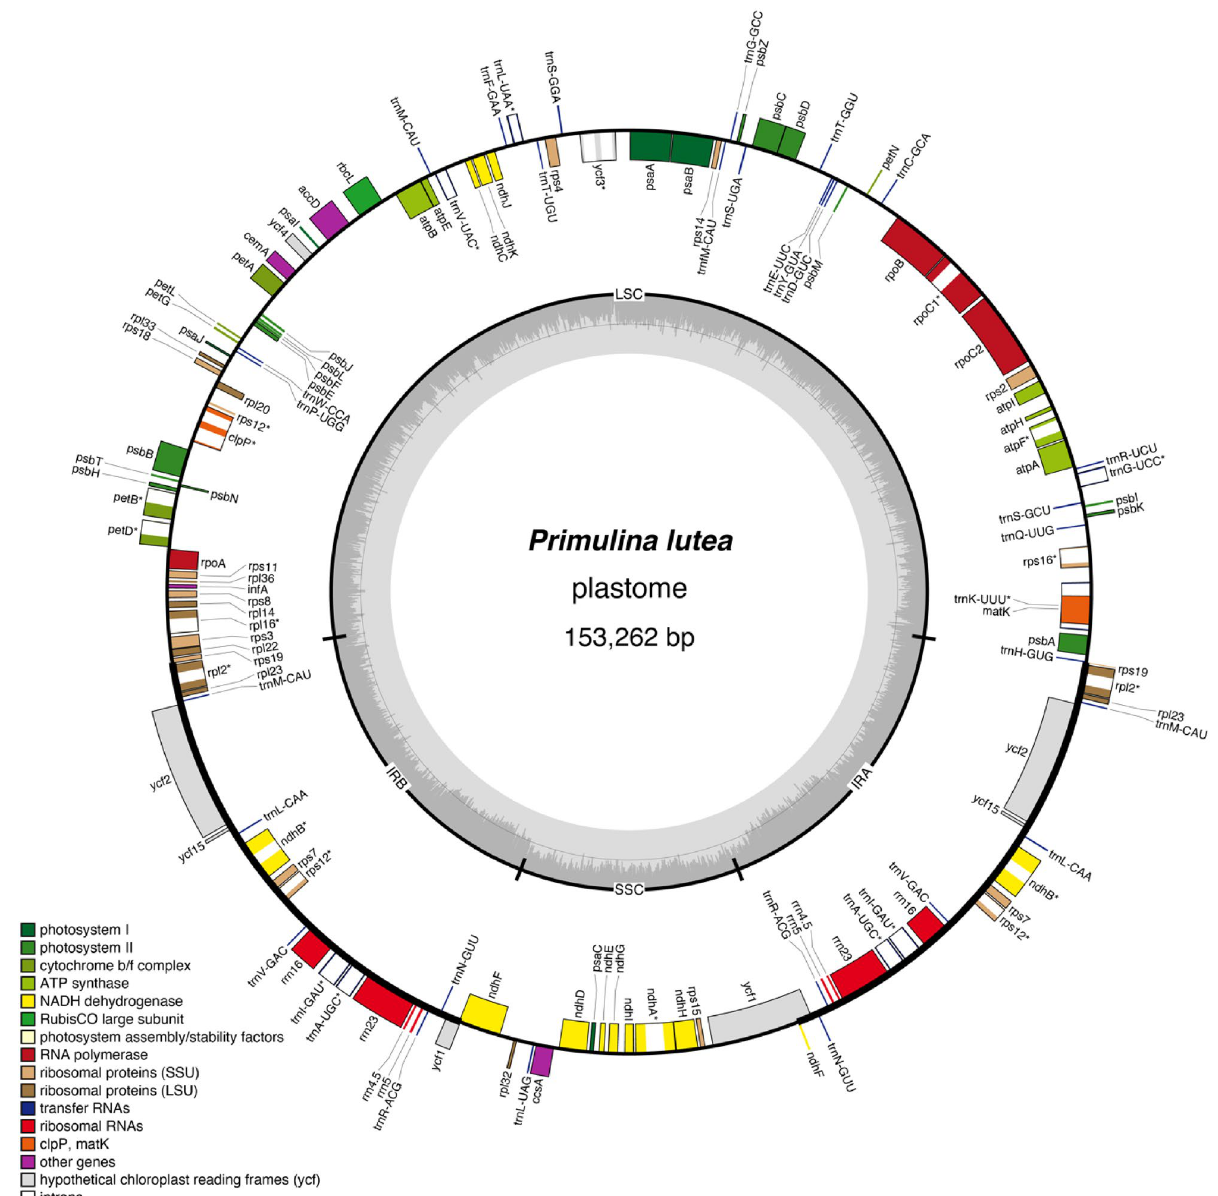
Figure 1. The plastome map of Primulina lutea . Genes drawn on the inner side of the outer circle are transcribed clockwise, and those on the outer side are transcribed counterclockwise. IRs are shown in bold line in the outer circle. The inner circle indicates GC contents across the genome with lighter gray indicating AT contents. Genes belonging to different functional groups were shown in different colors. Gene name ends with asterisk (*) indicates the intron containing